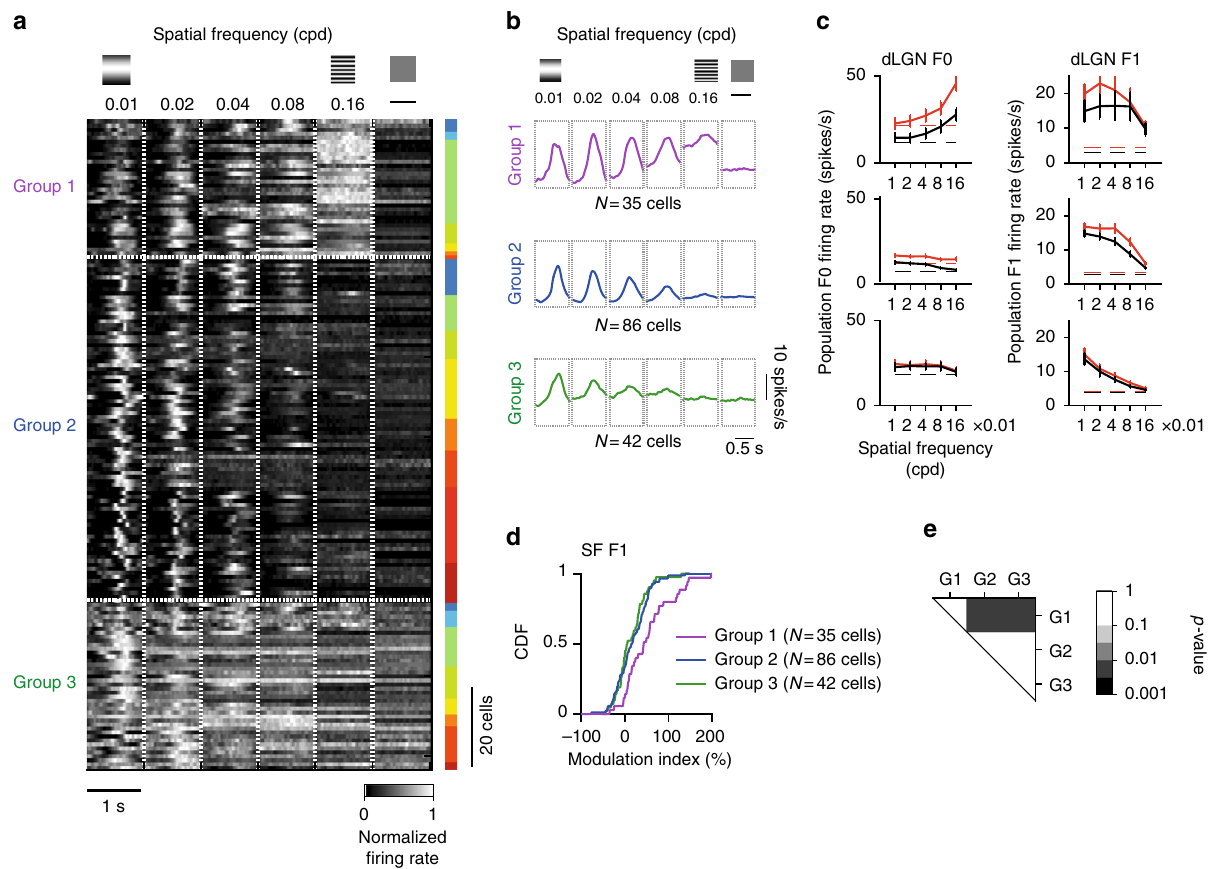
Fig. 7 Preferential modulations of dLGN neurons with nonlinear responses to high spatial frequencies. a Grouping of dLGN cells ( N = 163) based on normalized cycle averages to the spatial frequency stimulus and blank (30 – 50 trials). Cells were separated in three groups (Group 1, N = 35 cells, in purple; Group 2, N = 86 cells, in blue; Group 3, N = 42 cells, in green). Right inlet represents the correspondence of neurons to each experiment ( N = 15 experiments, N = 8 mice). b Mean of the cycle averages for the groups in a . c Average F0 (left) and F1 (right) responses of cells in each group to the spatial frequency stimulus (same cells as in b ). Scale bar for cycle averages is 10 spikes/s. d Response (F1) modulation index of individual groups to the